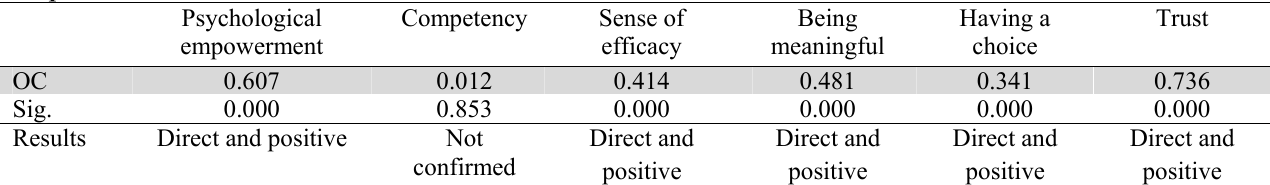
The results of Pearson correlation ratio between organizational commitment and psychological empowerment